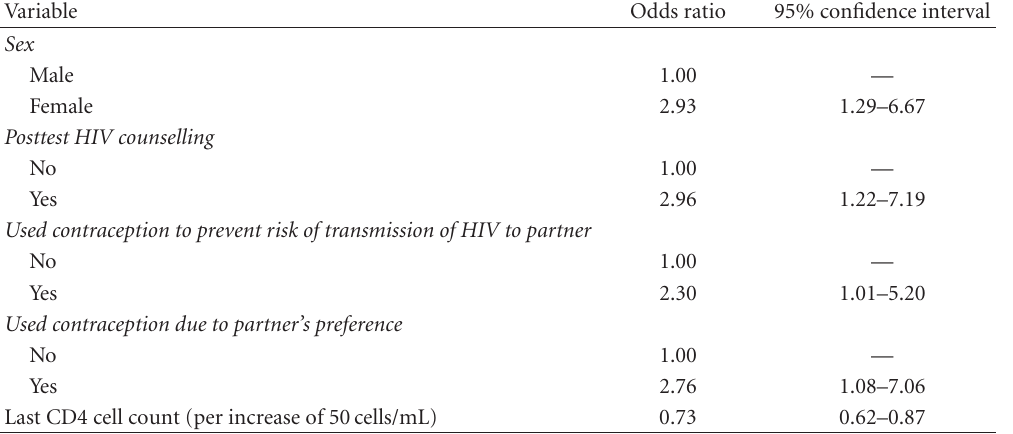
Table 3: Correlates of dual-contraceptive methods use among married persons living with HIV in India